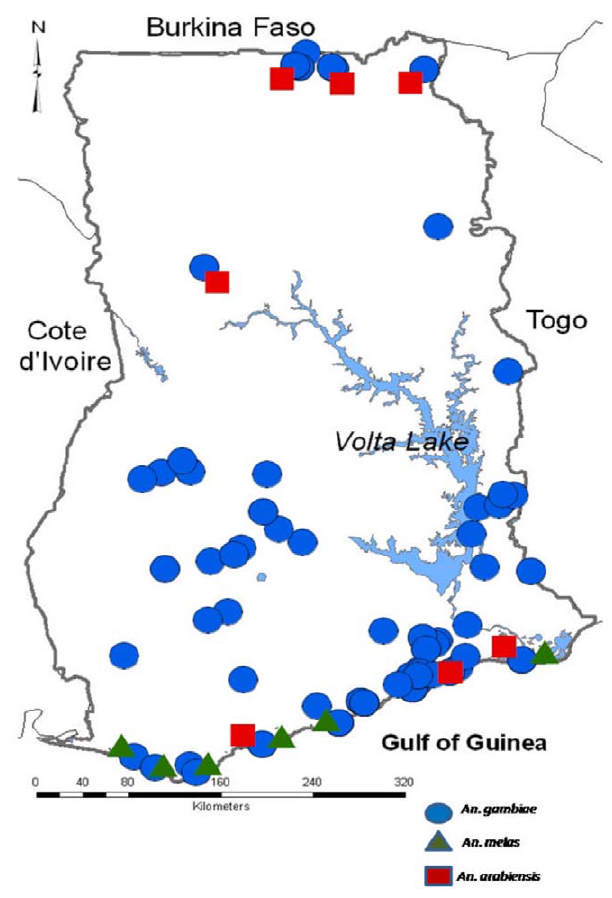
Figure 1. Distribution of An.gambiae s.l mosquitoes.